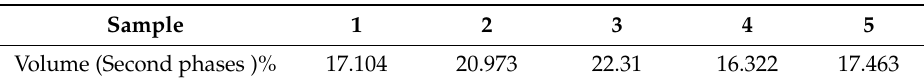
Table 9. ImageJ software statistical